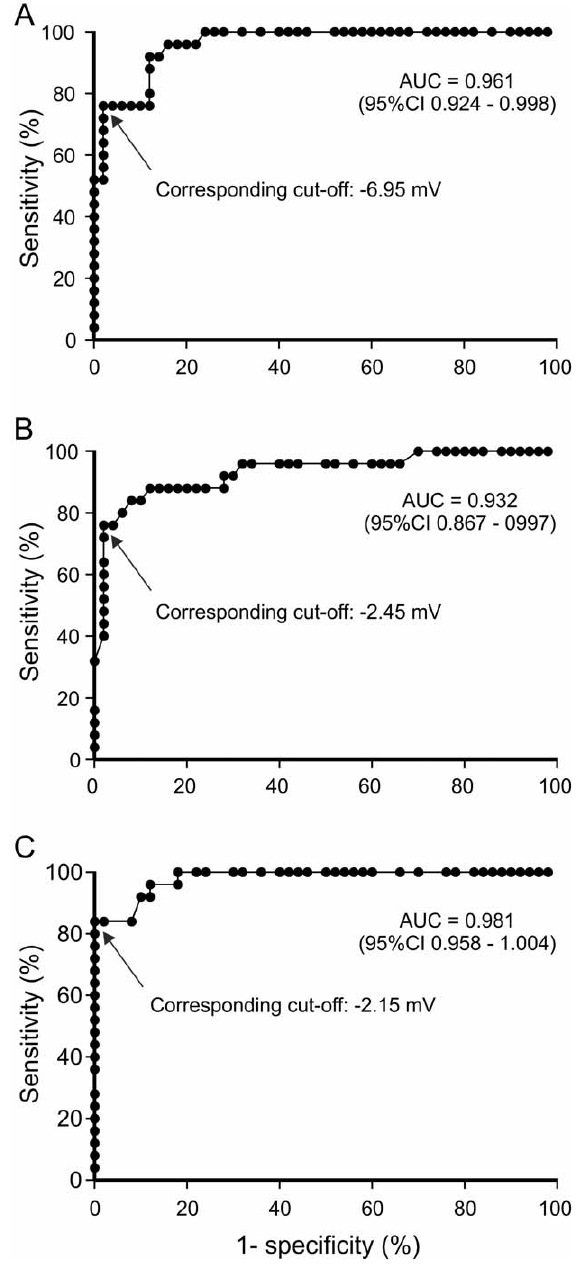
Figure 3. Cutoff point determination for nasal potential difference parameters distinguishing between FVB WT and F508del-CFTR mice. Receiver operating characteristics (ROC) curves for (A) baseline potential difference (V TE ), (B) amiloride response ( D V TEAmil. ) and (C) low Cl - solution response ( D V TElowCl- ), for WT and F508del-CFTR FVB mice are shown. AUC: area under the curve; 95% CI: 95% confidence interval. Cutoff points were determined by the best positive likelihood ratio of